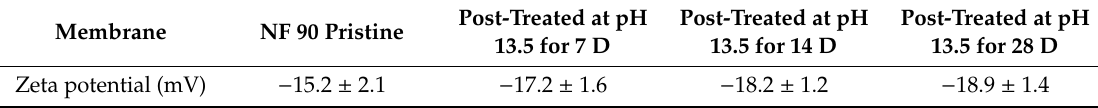
Table 2. Zeta potential of pristine and post-treated NF 90 membranes at pH 5.6 ( n = 3). Membrane